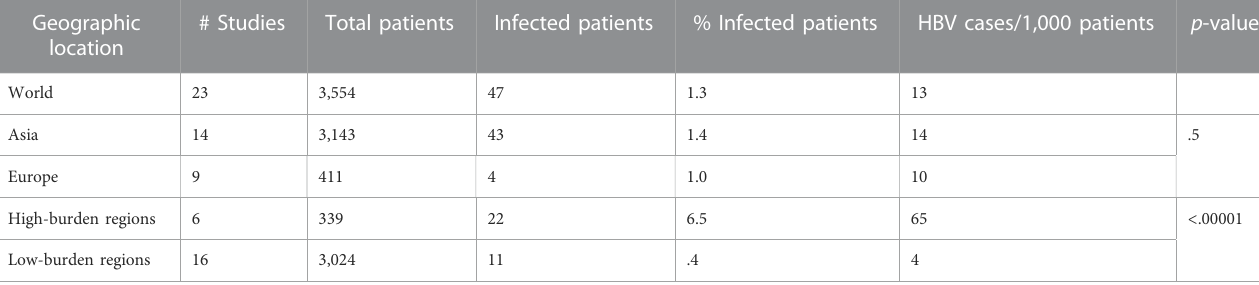
TABLE 2 Interregional differences in the frequency of HBV infection in patients receiving TNF α inhibitors. Geographic # Studies Total patients Infected patients % Infected location